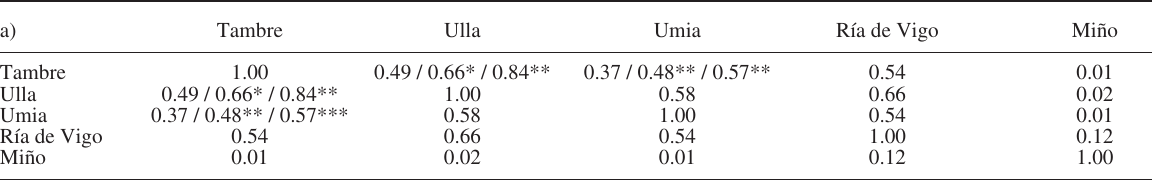
Table 3. – Correlation matrixes ( r ) of runoff estimated at the mouth of river basins (95% significance level). Matrixes are separated into northern (a) and southern rivers (b) due to the higher correlation among rivers flowing into Rías Baixas compared to those flowing into southern regions. The relocation of the gauging station of River Tambre at the end of 2001 resulted in different correlations based on time periods before and after this date.